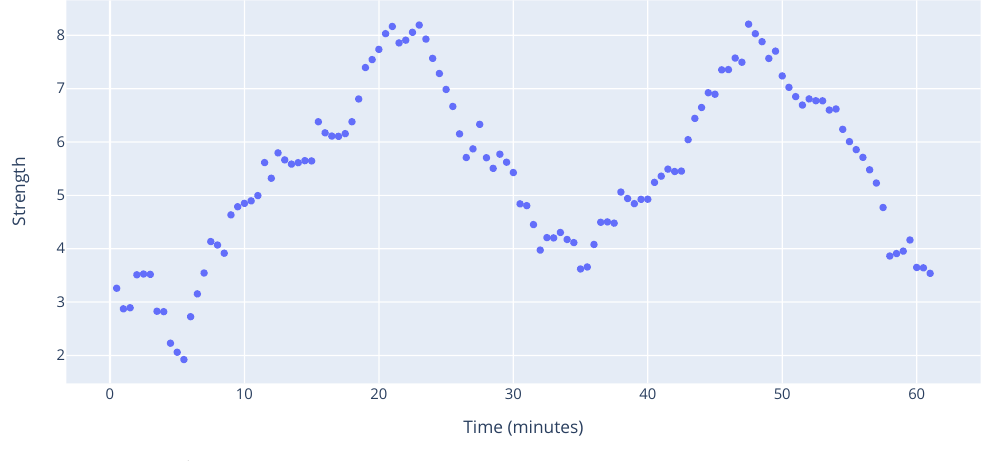
Figure 19. Strength.